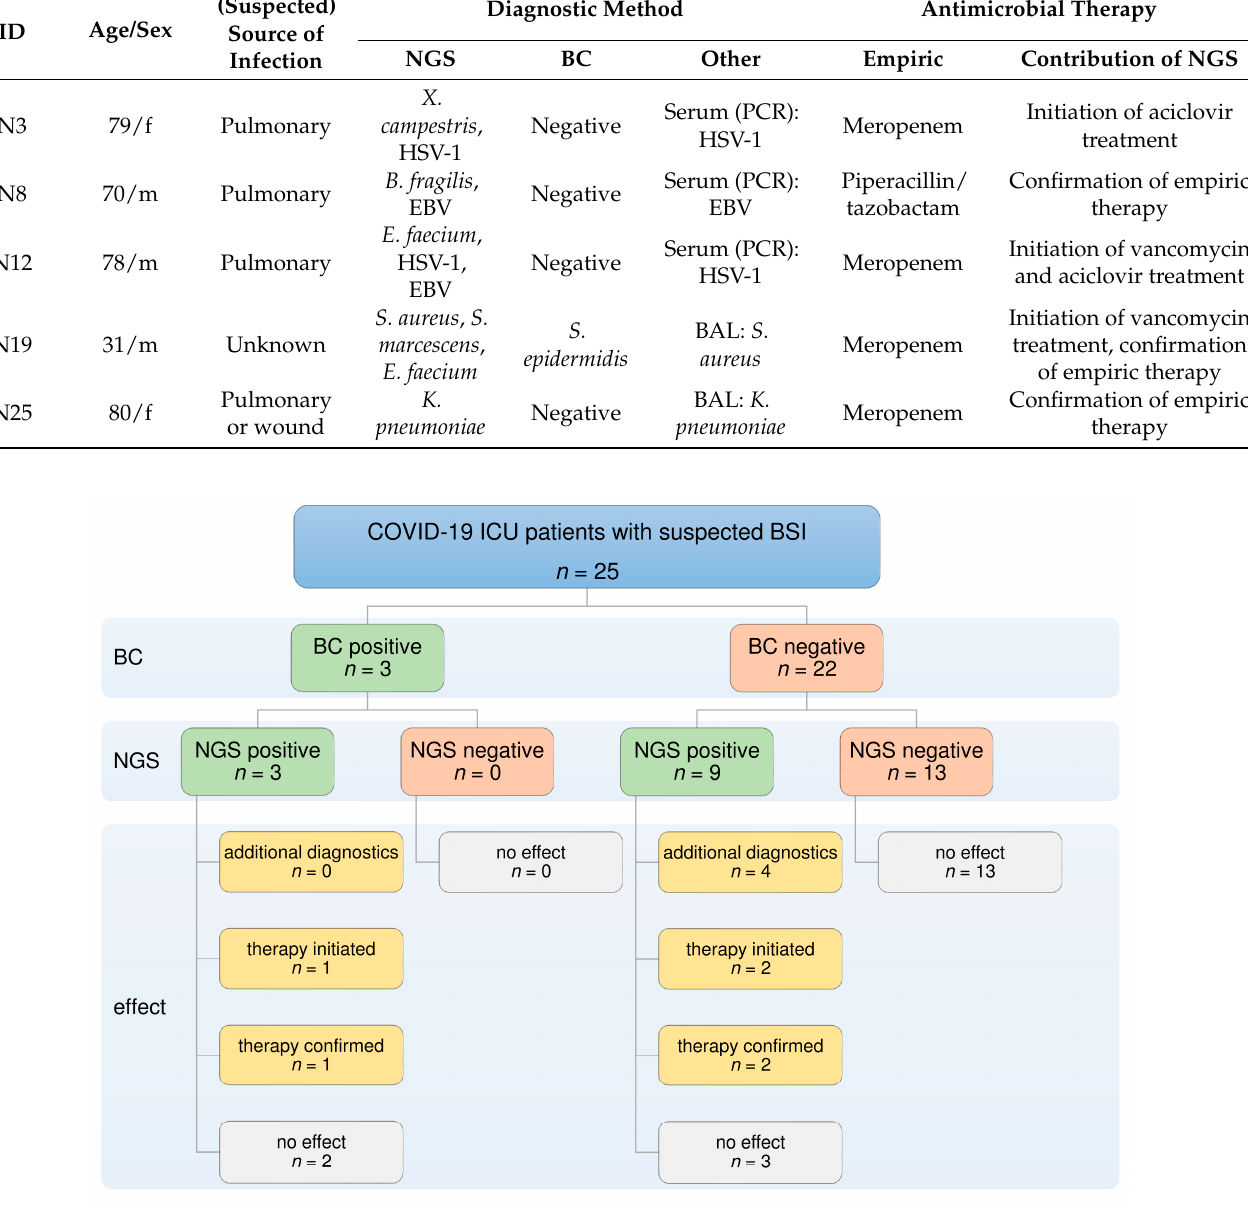
Figure 1. Diagnostic and therapeutic contribution of additional NGS considering BC positivity. BC failed to detect relevant pathogens in 22 of 25 cases. In six of these cases, additional NGS led to further diagnostic tests or contributed to the optimization of antimicrobial therapy. BC: blood culture; BSI: bloodstream infection; NGS: next-generation sequencing. Table 3. Contribution of NGS to the optimization of antimicrobial therapy. NGS results led to the initiation of four targeted therapies in three cases. Aciclovir was administered in two cases after HSV-1 was detected by NGS and confirmed by PCR. Vancomycin was started in two cases following the detection of E. faecium by NGS. In three cases, following pathogen detection by NGS, ongoing empiric therapy was considered appropriate and was continued accordingly. BAL: bronchoalveolar lavage; BC: blood culture; EBV: Epstein–Barr virus; HSV-1: herpes simplex virus type 1; NGS: next- generation sequencing; PCR: polymerase chain reaction.